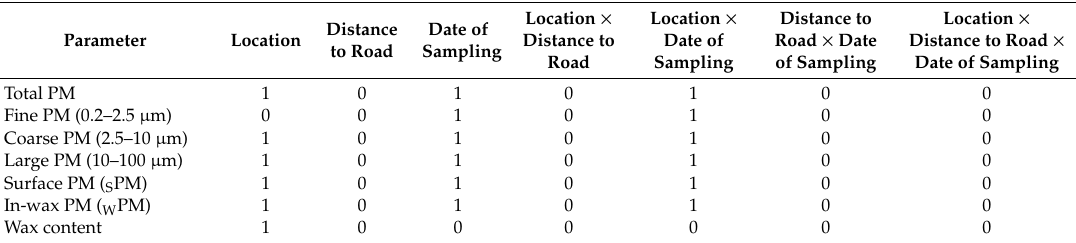
Table 6. Summary of the main e ff ects and interactions of location (proximity to roads with di ff erent tra ffi c intensity), distance to road, and date of sampling on particulate matter (PM) accumulation and wax content on apples, shown as significant (1) or not significant